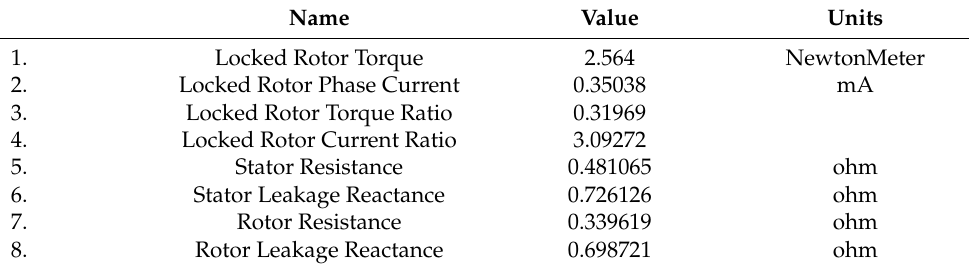
Table 1. Project calculation result window in tabular form.